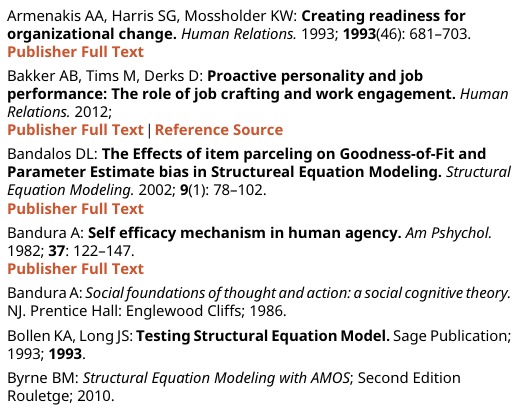
Figshare: The Respondent characteristics of Transformational Entrepreneurship case of a state-owned bank in Indonesia. https://doi.org/10.6084/m9.figshare.14731905.v1 (Gunawan, et al., 2021c). This project contains the following extended